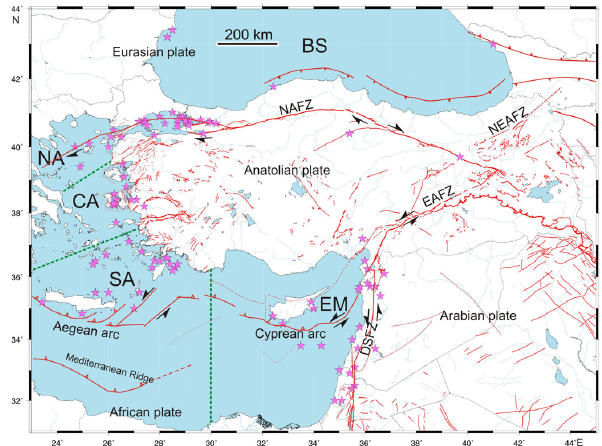
Fig. 1. The neotectonics of Turkey is characterized by three main strike-slip fault zone systems and a subduction zone along the Aegean and Cyprean arcs (S¸aro˘glu et al., 1992; Bozkurt, 2001). DSFZ – Dead Sea Fault Zone, EAFZ – East Anatolian Fault Zone, NAFZ – North Anatolian Fault Zone, NEAFZ – Northeast Anato- lian Fault Zone. Stars indicate the source locations of the tsunamis defined in the present